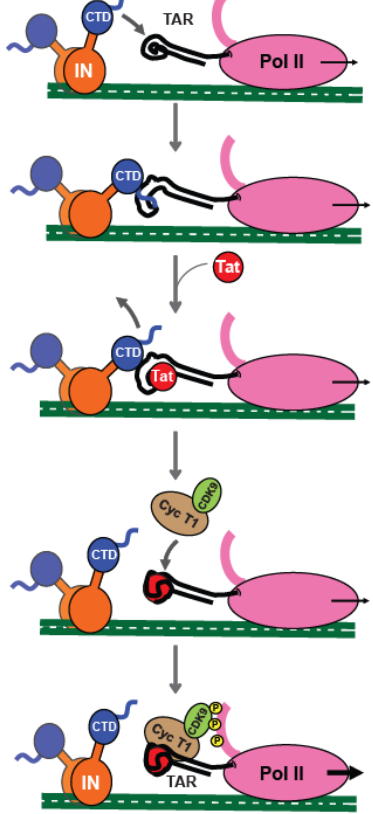
Figure 5. Cartoon of the working Model proposed for the interplay of IN-CTD, Tat and TAR during the early stage of HIV-1 proviral transcription. Once the integration has taken place, IN interacts with nascent TAR transcript through its CTD, directly interacting with the major groove and the hexaloop, thanks to its C-terminal tail. This binding induces TAR conformational changes, which promote the interaction of Tat with its substrate. Afterwards, Tat displaces IN-CTD from TAR and recruits the SEC complex in order to boost Pol II transcription.